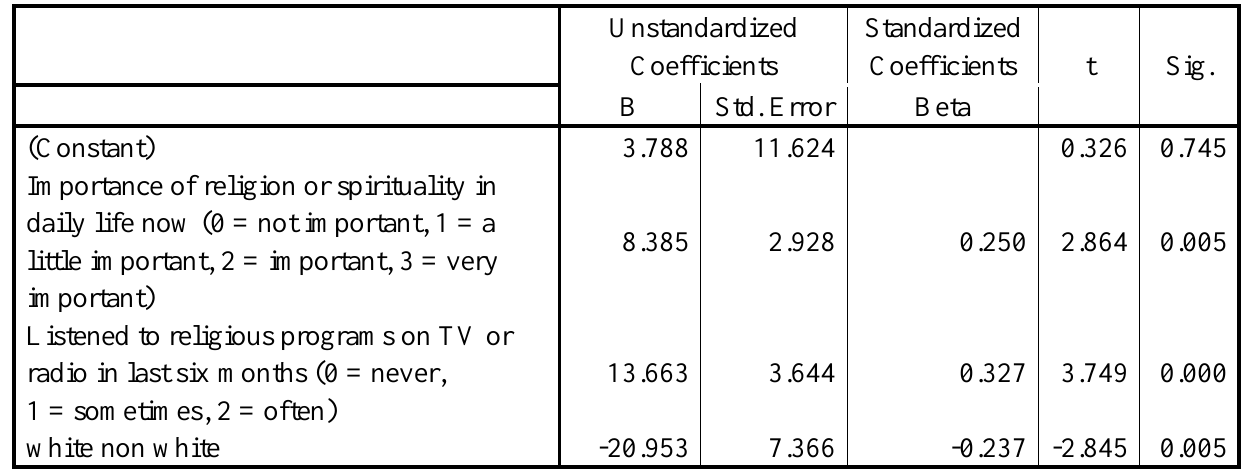
Table 5. Linear Regression Model Predicting Number of Attendances for Women Who Took an H/S/R Assessment at